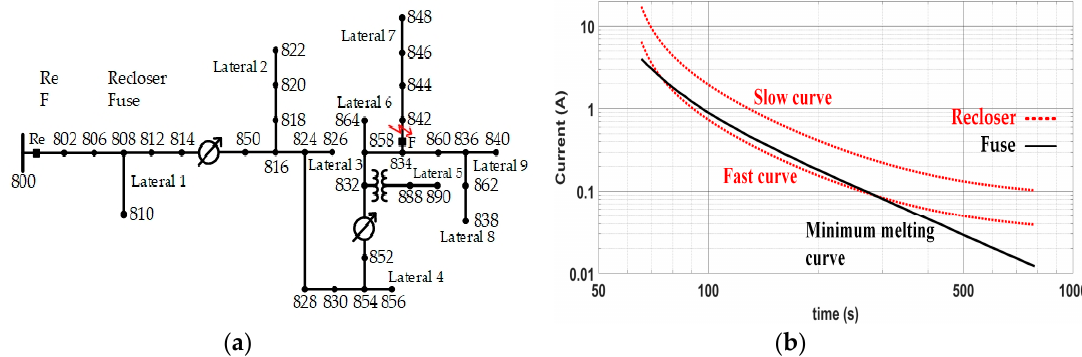
Figure 7. IEEE-34 node radial test feeder: ( a ) one-line diagram; ( b ) time–current curve of a recloser–fuse.